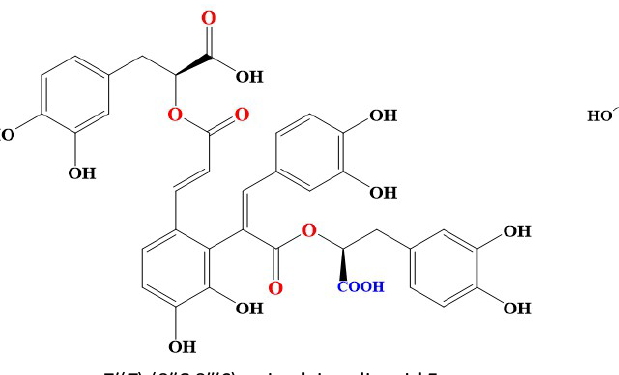
Figure 5. Chemical structures of salvianolic acid B